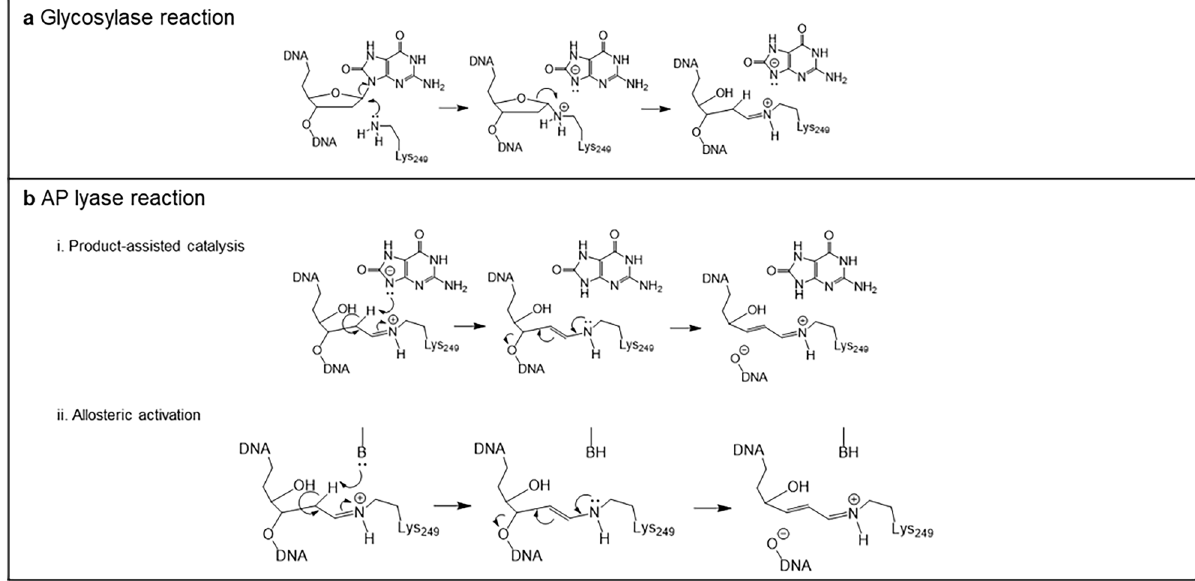
( b ) the AP lyase one with the projected re-arrangements resulting from product assisted catalysis (i) or allosteric modification